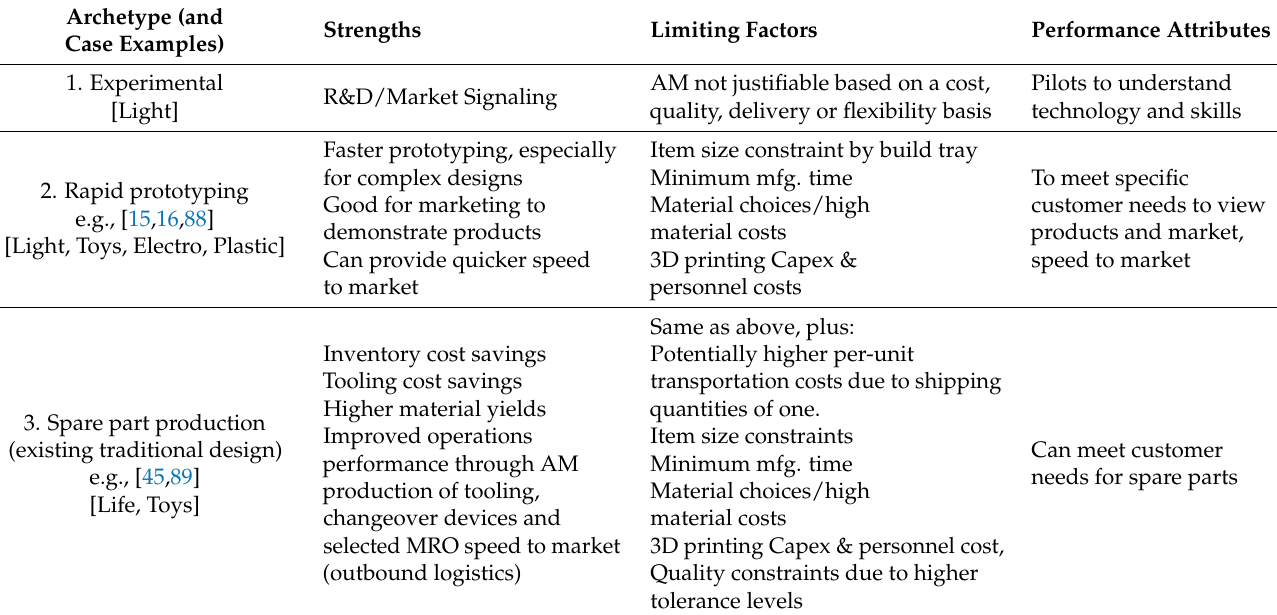
Table 1. Archetypes 1–5 represent very different adaptations of AM in support of end